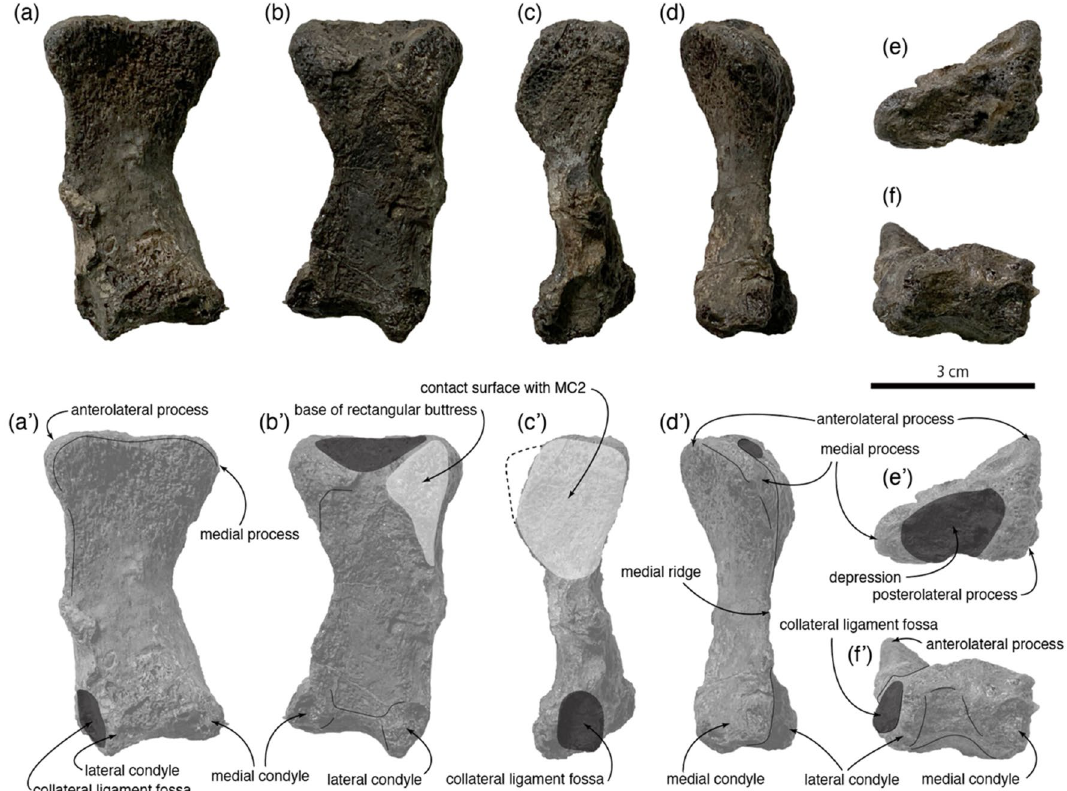
Figure 3. Right metacarpal I of Paralitherizinosauruss japonicus gen. et sp. nov. in anterior ( a ), posterior ( b ), lateral ( c ), medial ( d ), proximal ( e ), and distal ( f ) views. ( a ′ ) to ( f ′ ) are corresponding images in black and white with labels. This figure was created by using Adobe Photoshop 21.2.0 and Adobe Illustrator 24.2.1 (https:// www. adobe.